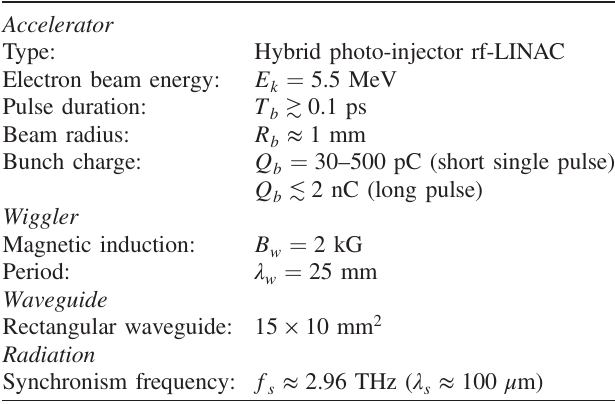
TABLE I. Operational parameters for the THz